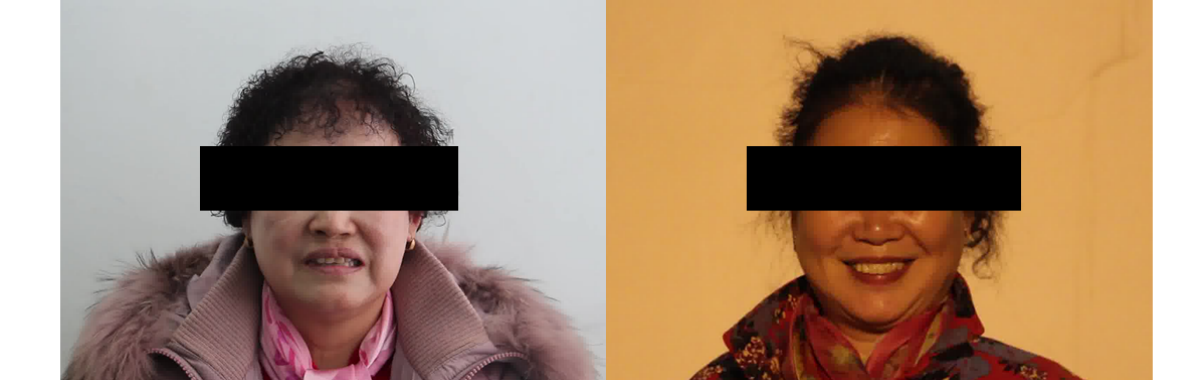
Figure 1. Smiles of a patient with Parkinson disease (left) and person without Parkinson disease (right).